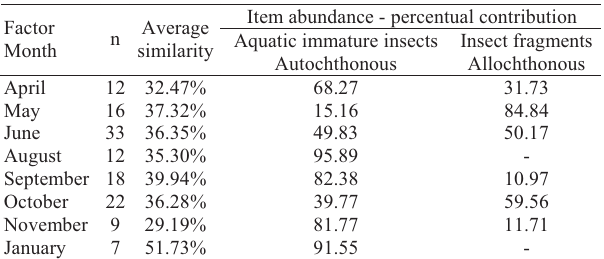
Table 4. SIMPER results, showing the contribution percentages of the most representative item abundance for each month